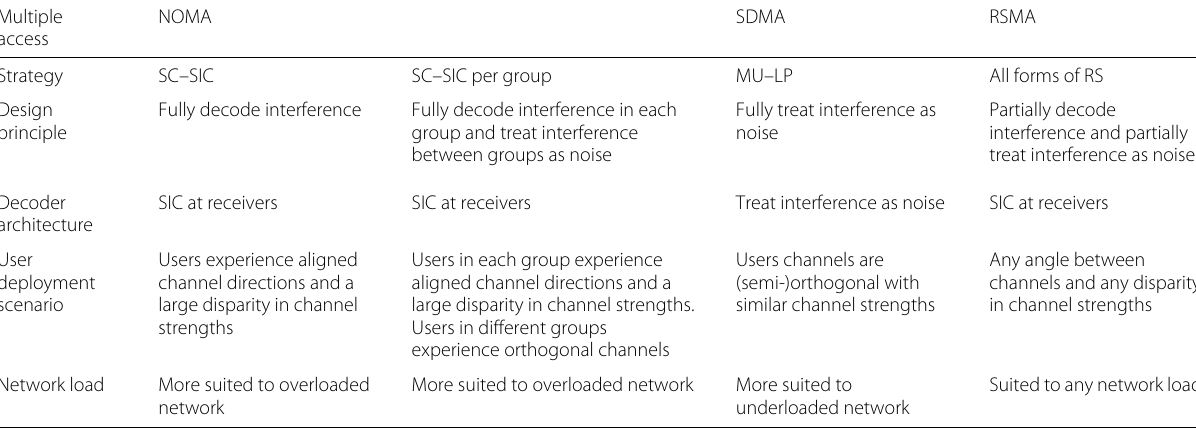
Table 2. In Table 2, RS refers to the generalized RS of Section